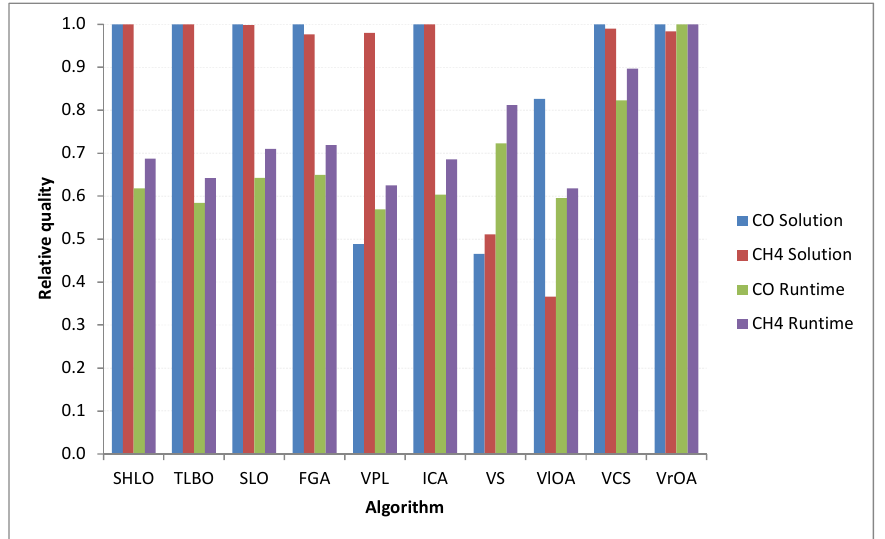
Figure 4. Performance indicators for solution quality and execution time for the ten algorithms considered for the two optimization problems (SHLO = Simple Human Learning Optimization; TLBO = Teaching–Learning-Based Optimization; SLO = Social Learning Optimization; FGA = Football Game Algorithm; VPL = Volleyball Premier League; ICA = Imperialist Competitive Algorithm; VS = Viral System, VlOA = Virulence Optimization Algorithm; VCS = Virus Colony Search; VrOA = Virus Optimization Algorithm).